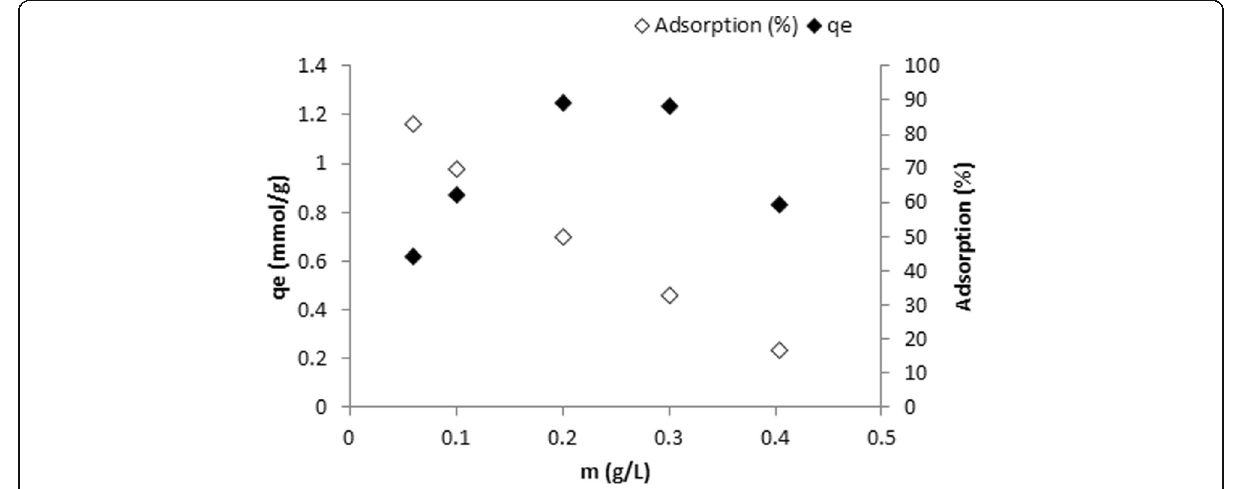
Fig. 12 Adsorbent dosage effect on Cr (VI) adsorbed by N6,6/GO (equilibrium time: 6 h, pH: 2, temperature: 25